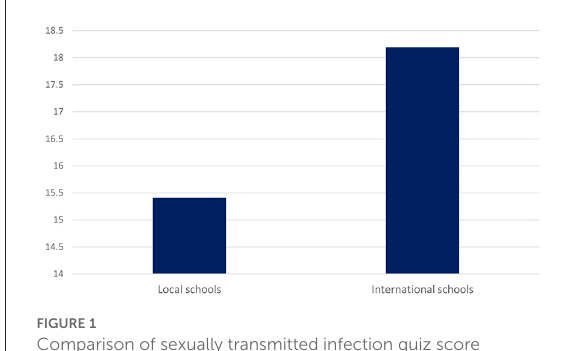
FIGURE1 Comparison of sexually transmitted infection quiz score between students from local schools and those from international schools. Compared with students from local secondary schools, those who attended international secondary schools in Hong Kong had a significantly higher STI quiz score (18.19 vs. 15.41, p = 0.003). Cohen’s d effect size was 0.45.